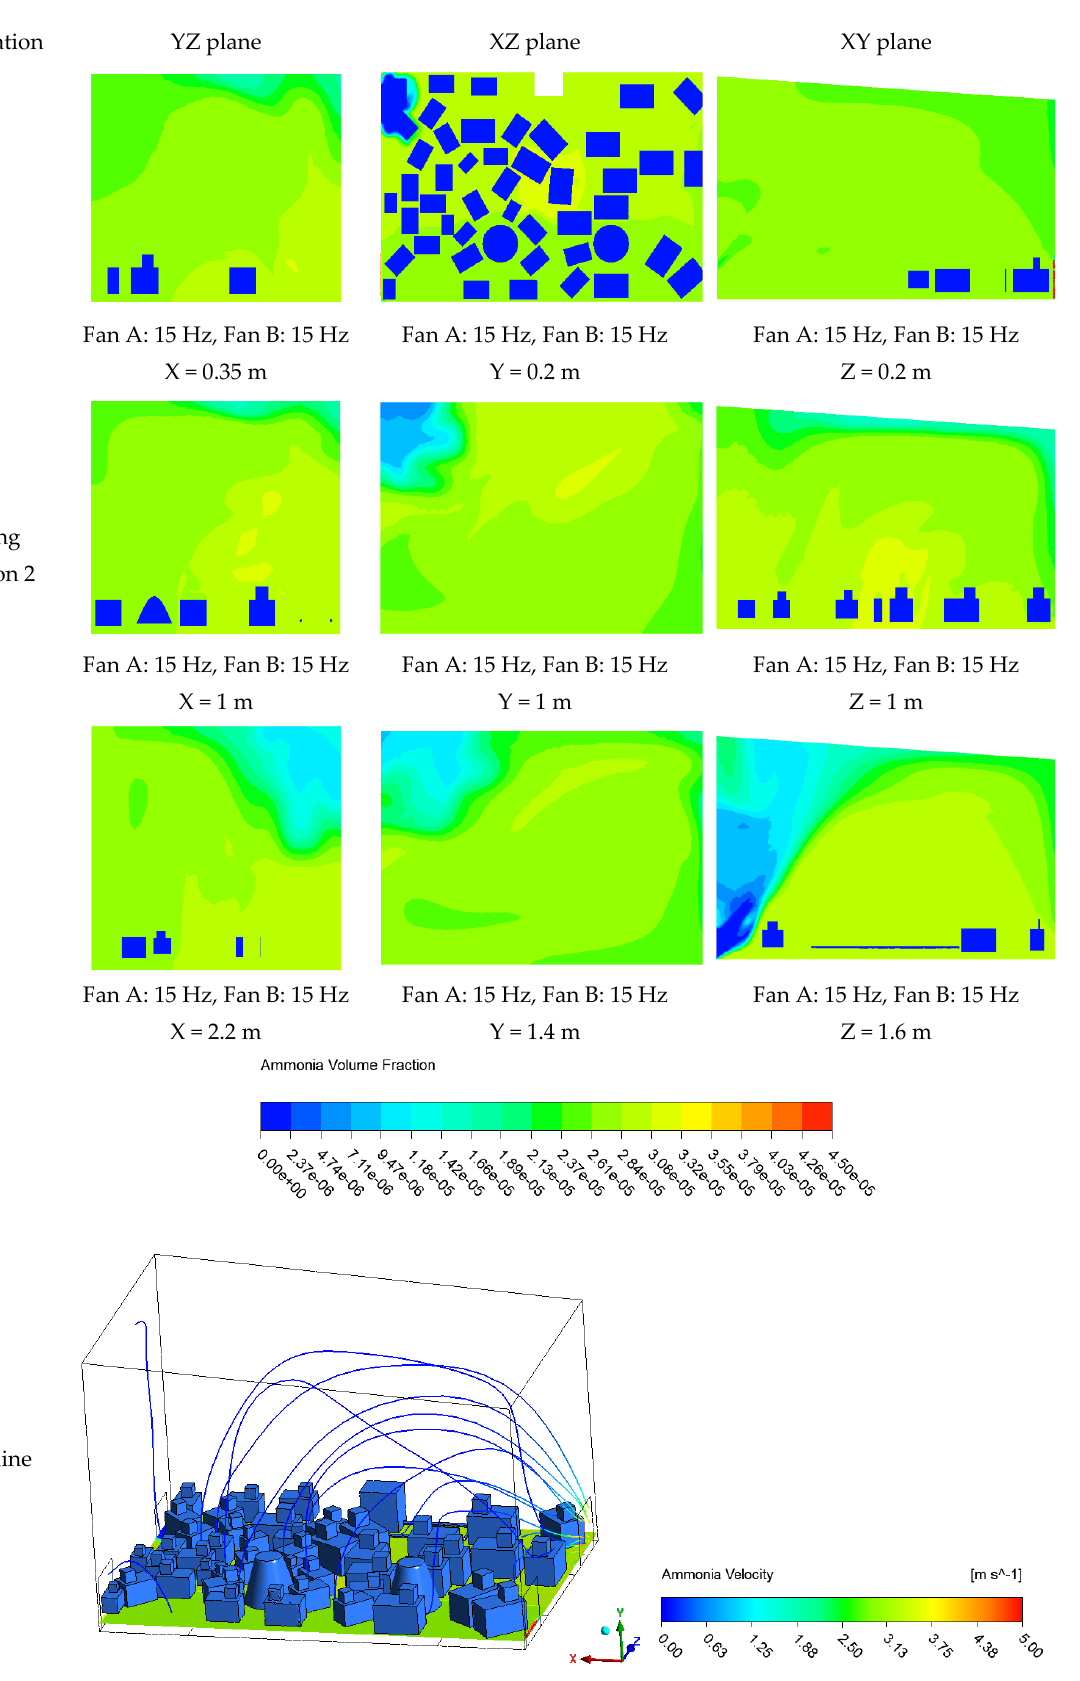
Figure 10. Simulation results of ammonia concentration distribution under working condition 2.